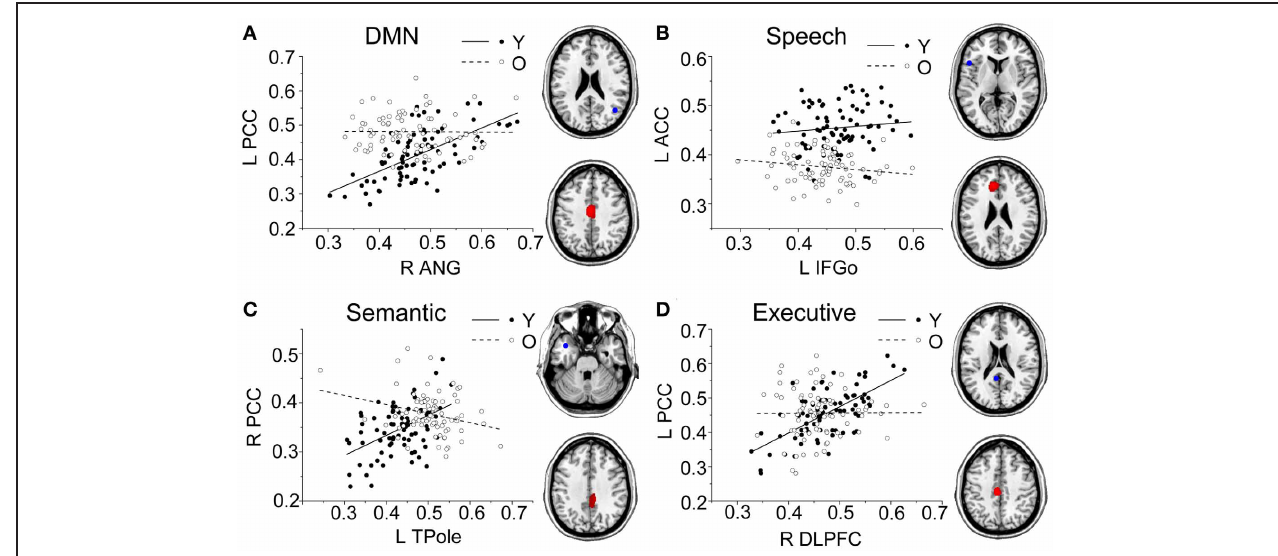
FIGURE 5 | Group differences for the young vs. the old subjects. Significant between-group differences within the DMN (A) , speech (B) , semantic (C) , and executive (D) structural covariance networks were found. For each network, the region of interest (upper) and region showing the most significant structural association (lower) are presented on the right, and a plot of slop differences between the seed region and a 4-mm